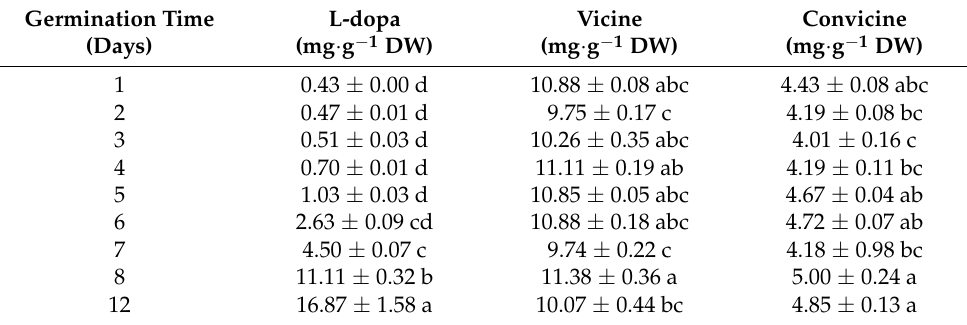
Table 1. Changes in L-3,4-dihydroxyphenylalanine (L-dopa), vicine, and convicine contents in germinating faba